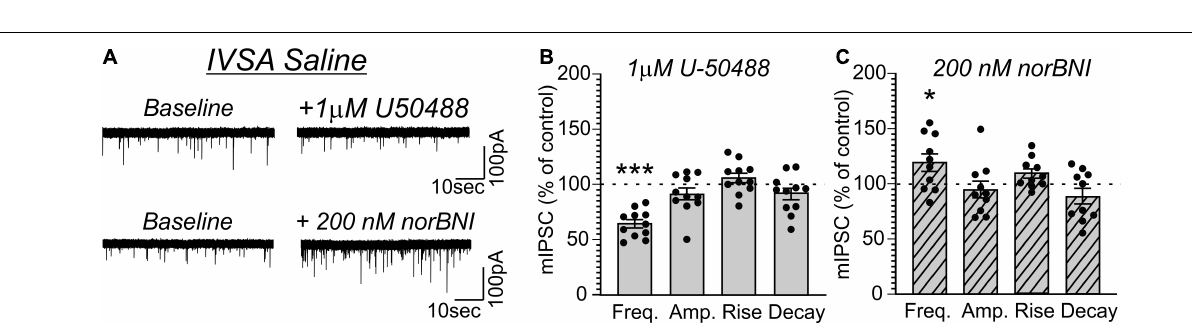
FIGURE 5 | (A) Representative mIPSC recordings from CeA neurons from female Wistar rats self-administering Saline (left panel), MDMA (middle panel), or Pentylone (abbreviated PENT, right panel). (B) Scaled mIPSC averages illustrating the effects of MDMA-LgA and Pentylone-LgA on mIPSC amplitudes and kinetics. Bars in represent means ± S.E.M. of mIPSC (C) frequencies, (D) amplitudes, (E) rise, and (F) decay times. Differences between groups were calculated using a one-way ANOVA with Dunnet post hoc analyses. (*) = P < 0.05, (**) = P < 0.01, (***) = P < 0.001.